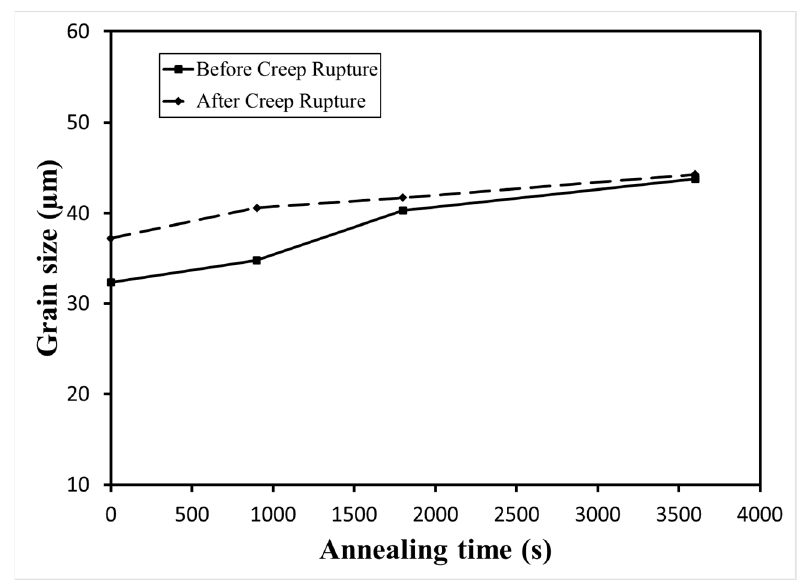
Figure 15. Comparison of grain sizes before and after the creep rupture test.